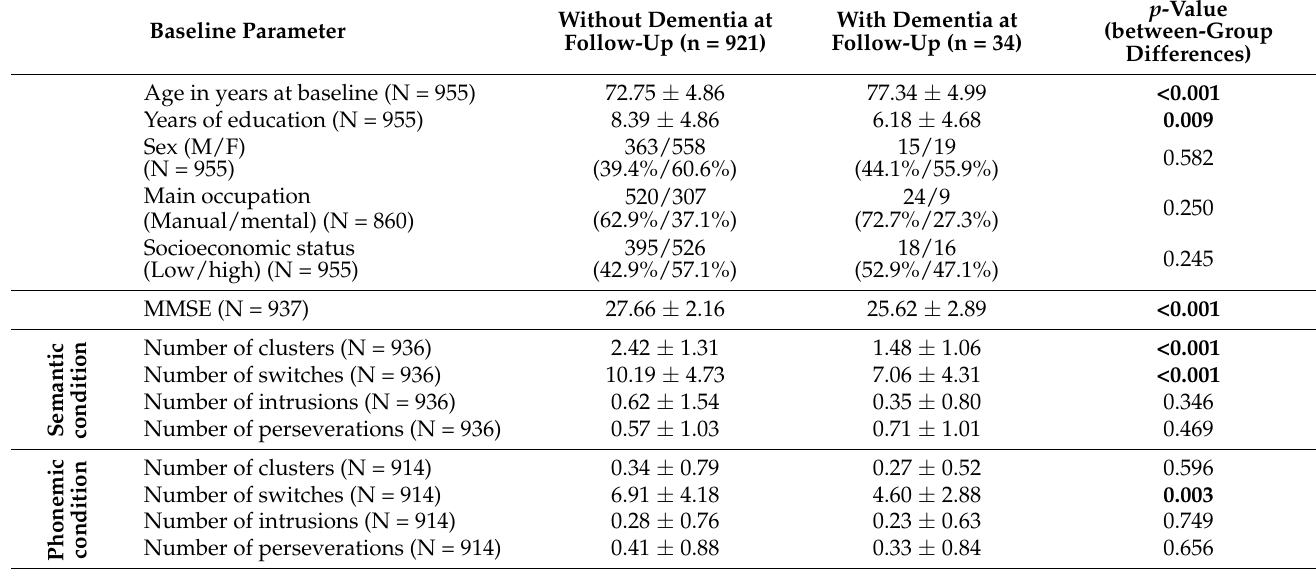
Table 1. Baseline characteristics of cognitively normal participants according to the diagnosis of dementia or not at